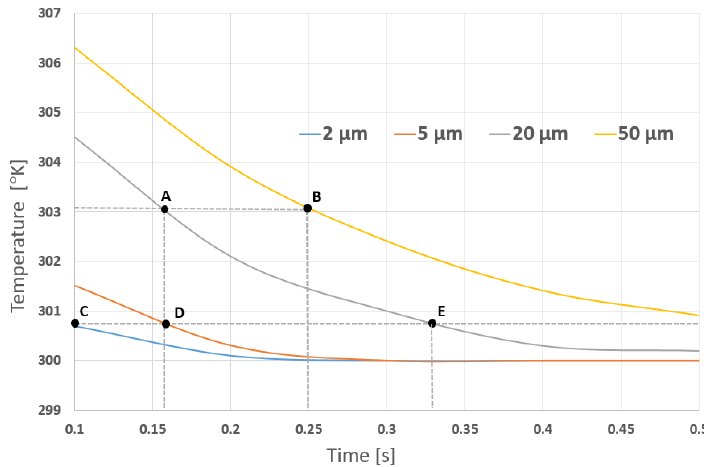
Figure 4. Temperature vs. Time for different